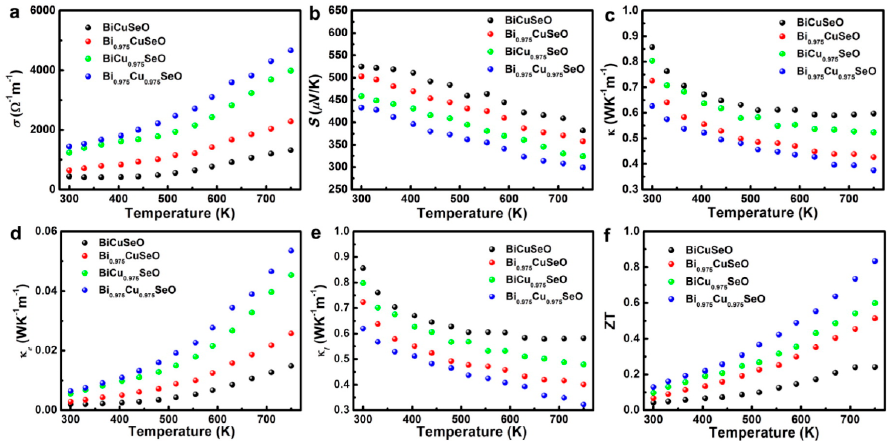
Figure 14. Thermoelectric properties of Bi 1 − x Cu 1 − y SeO samples, pristine BiCuSeO (black), Bi 0.975 CuSeO (red), BiCu 0.975 SeO (green), Bi 0.975 Cu 0.975 SeO (blue). ( a ) The electrical conductivity; ( b ) the Seebeck coefficient; ( c ) the total thermal conductivity; ( d ) electrical thermal conductivity; ( e ) lattice thermal conductivity; and ( f ) the figure of merit ZT. Reprinted (adapted) with permission from Reference [9]. Copyright 2015, American Chemical Society.